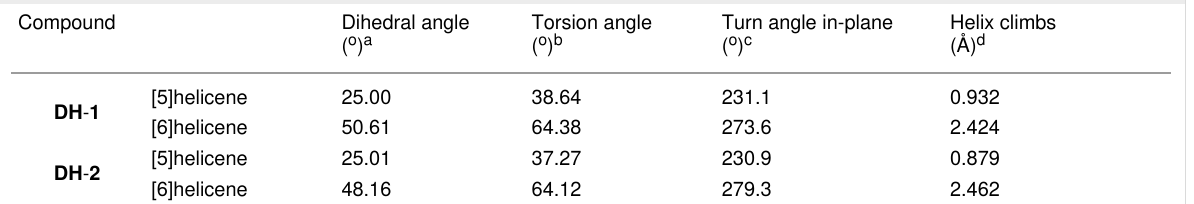
Table 1: Crystal parameters of helicenes DH - 1 and DH - 2